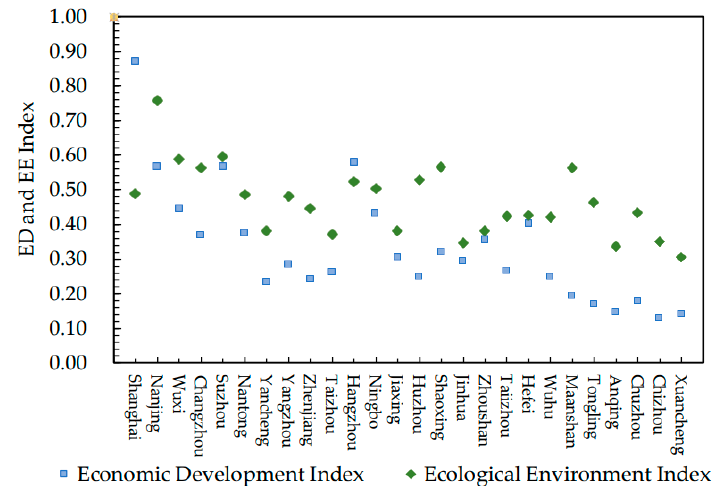
Figure 1. ED and EE Index of 26 Cities in YUA in 2019.